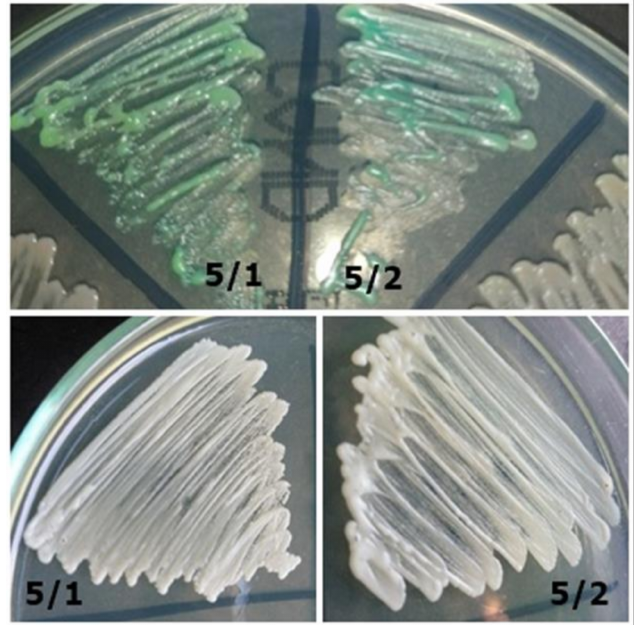
Figure 3. Strains 5/1 and 5/2-morphology on CHROMagar Candida and Sabouraud 2 with chloram- phenicol medium (private collection).